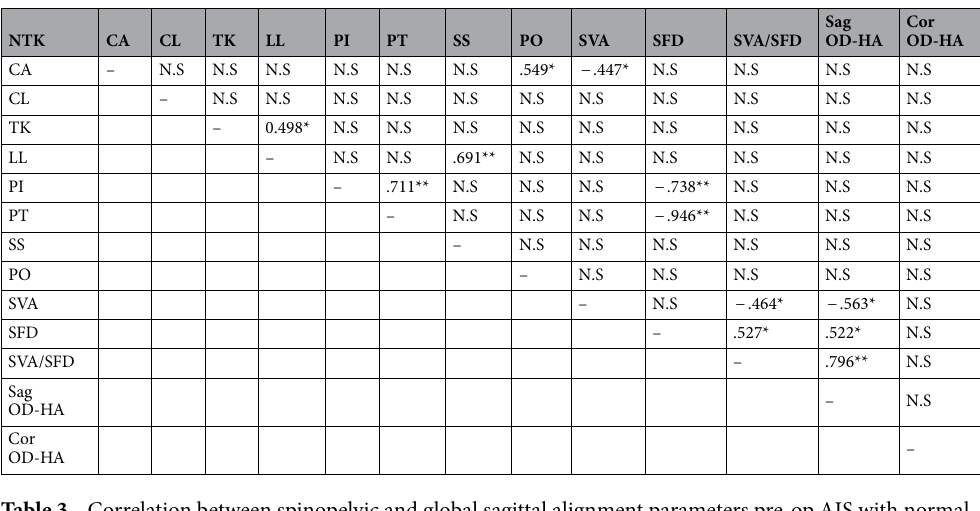
Table 3. Correlation between spinopelvic and global sagittal alignment parameters pre-op AIS with normal thoracic kyphosis (NTK). Significance level: * P < 0.05, ** P < 0.01. NTK normal thoracic kyphosis; CA Cobb